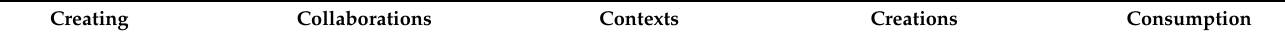
Table 1. C × C study designs. Creators: Level of trait EI (2 groups—high vs. low); Creating: Process tracing of emotions in a creative act; Collaborations: Working alone or together creatively; Contexts: Emotionally laden or emotionally neutral creativity task; Creations: Generating strategies to regulate emotion creatively, such as cognitive reappraisal; Consumption: Assessing willingness to adopt original products and level of emotional content that the products produce; Curricula: Training of EI and creative skills. Creators Creating Collaborations Contexts Creations